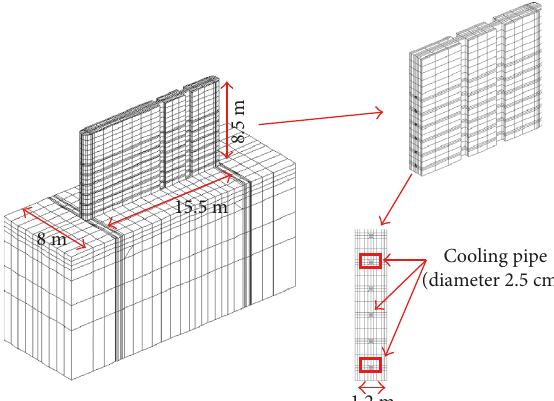
Figure 3: Finite element model with pipe cooling of the sluice